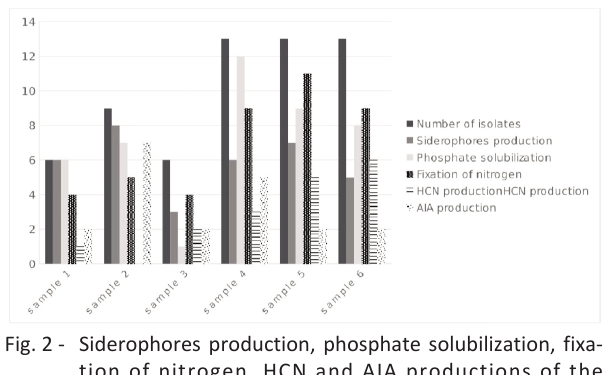
Fig. 2 - Siderophores production, phosphate solubilization, fixa- tion of nitrogen, HCN and AIA productions of the Rhizobacteria isolates of ucria (Ahaggar).